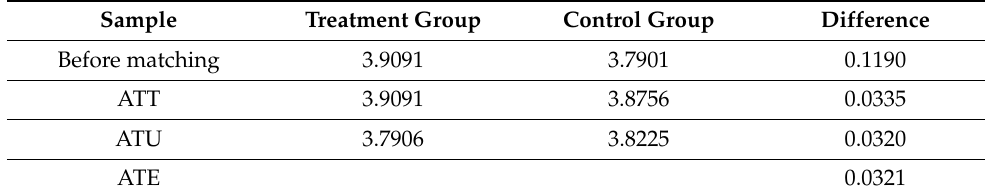
Table 5. Results based on propensity score matching.